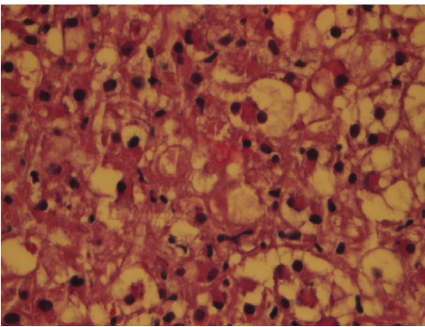
Figure 4: Haphazard arrangement of epithelioid cells with cleared- out cytoplasm.